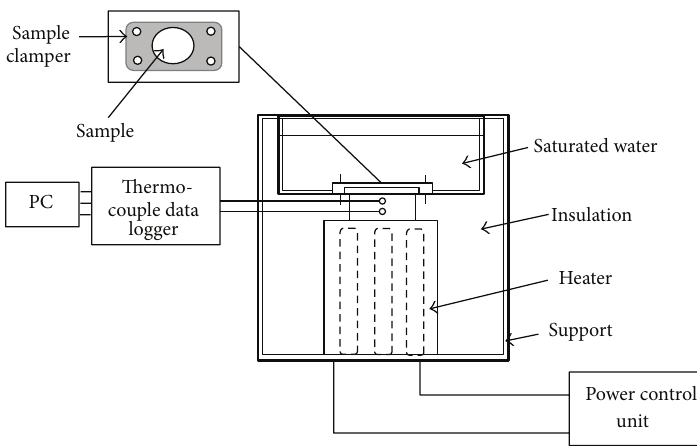
Figure 2: Schematic picture of heating system.